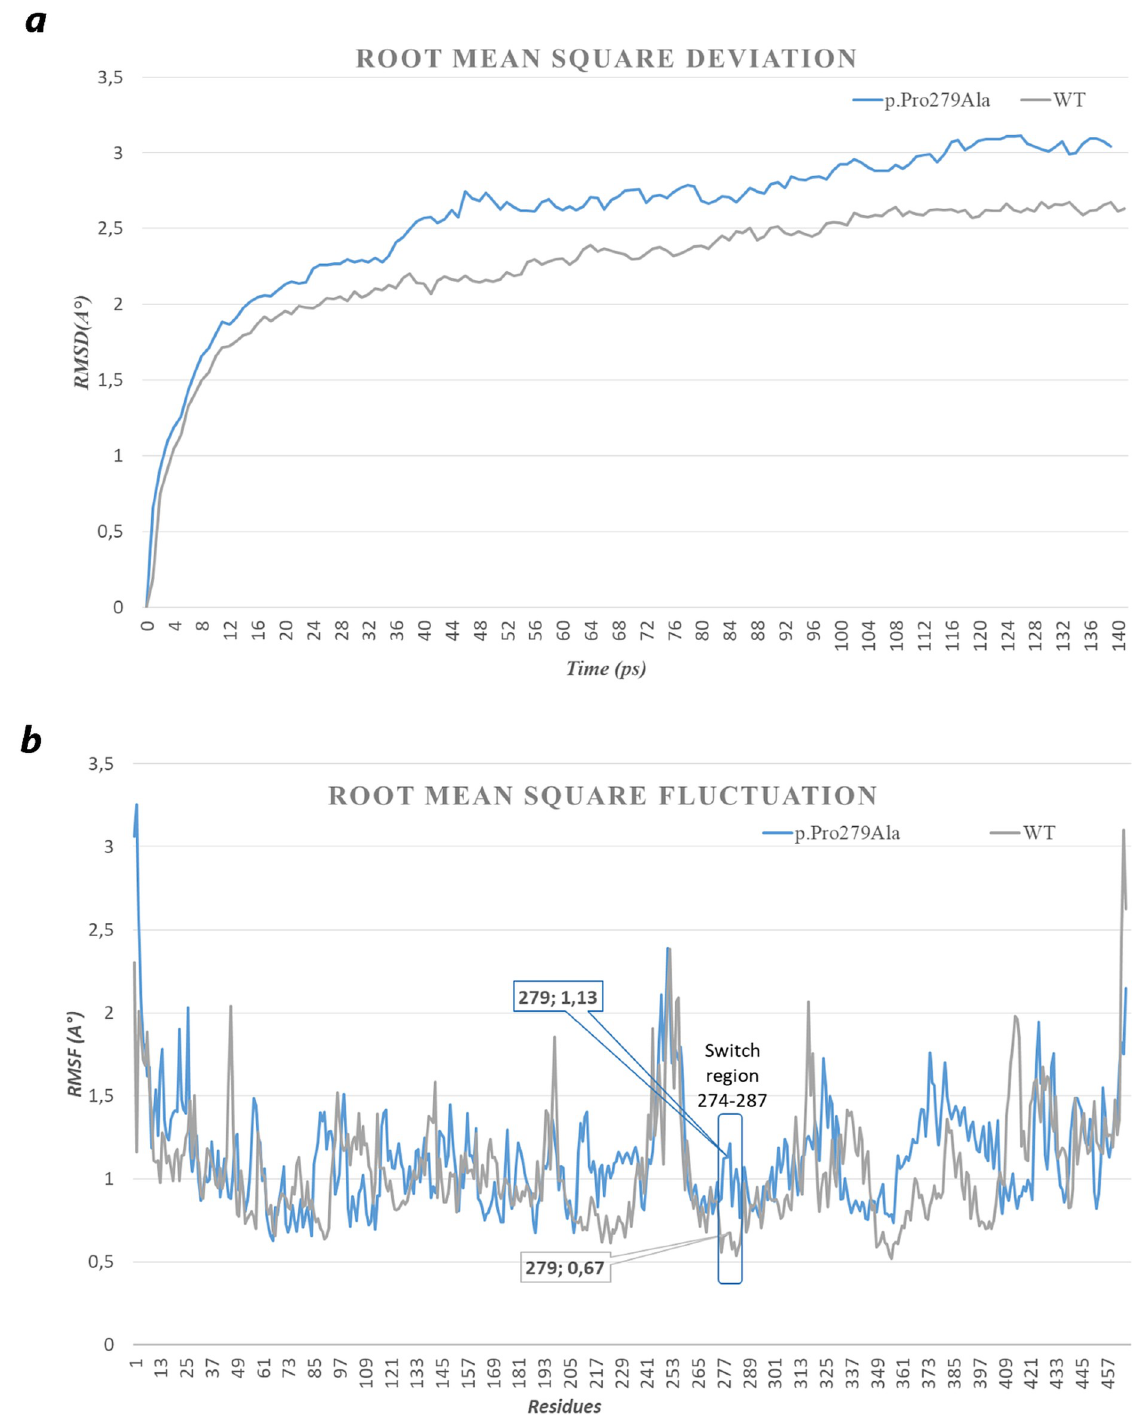
Fig 5. Analysis of simulation trajectory of the wild-type and mutated (p. Pro279Ala) NIPA4 protein for 140 ps. (a) Time evolution of backbone RMSD as a function of time, (b) RMSF of the C α atoms as a function of residue. A lesser value was found in RMSD for the wild- type (blue) than that the mutant protein (grey indicating a more stability for the wild-type than the altered protein. These results indicate that the flexibility of NIPA4 was improved due to the mutation on Pro279Ala. The superimposition of the RMSF of all amino acids of the wild- type with the p.Pro279Ala mutation indicates a strong modification in the region containing the mutation. This region was surrounded by a rectangle in (b). The fluctuation of the loop (274–287) clearly demonstrates the mobility of the mutated region compared to the wild-type, probably leading to the dysfunction of the Mg 2+ ion